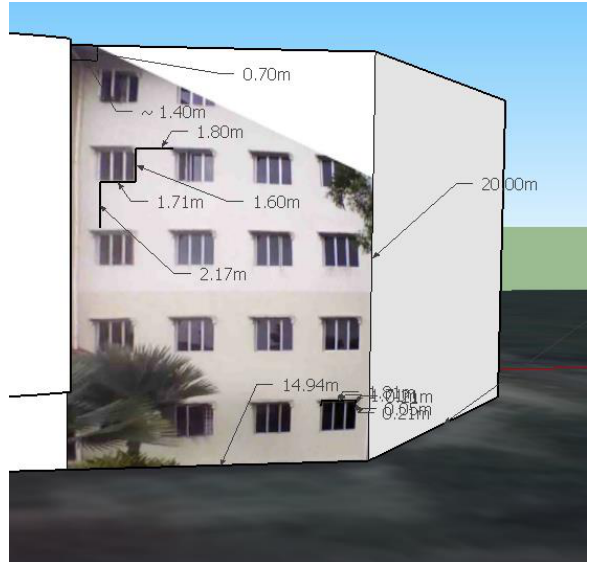
Figure 5. Parameters of DPF for automatic 3D modelling